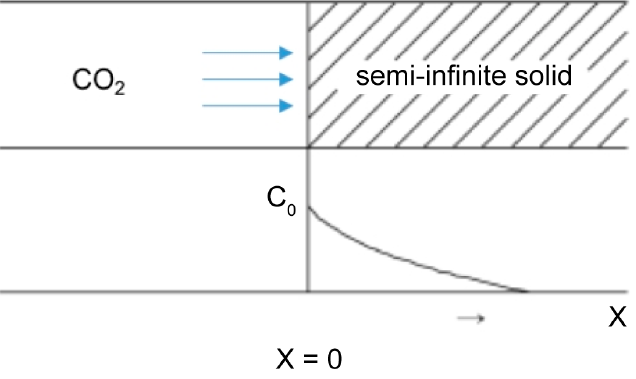
Figure 8. Carbonation in an OPC/ γ -C 2 S paste specimen.